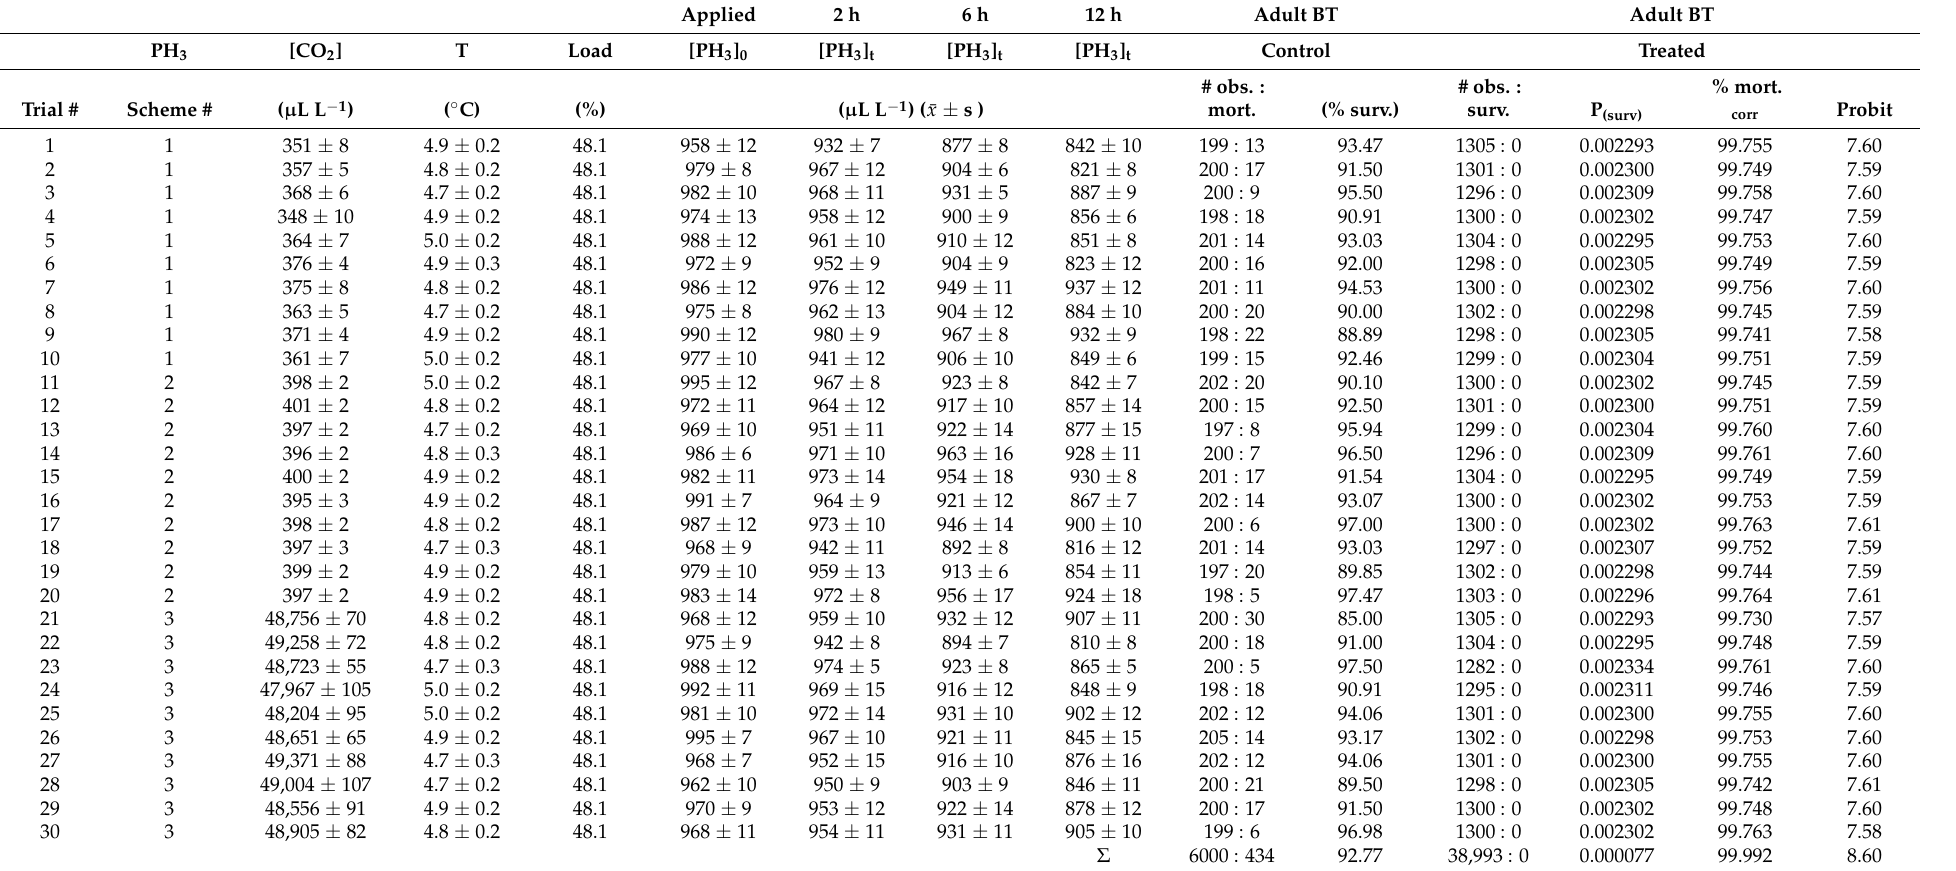
Table 1. Efficacy analysis and parametrics associated with confirmatory fumigations of adult bean thrips (BT), Caliothrips fasciatus, (Pergande) infesting navels of sweet oranges, Citrus sinensis (L.) having pulp temperature ( x ± 2 s ), T , and applied doses of ca. 1.5 g m − 3 (1000 ppmv ( µ L L − 1 )) delivered by three formulations of cylinderized phosphine − 1.6% phosphine by volume in nitrogen—Scheme 1, VAPORPH 3 OS ® —Scheme 2, and ECOFUME ® —Scheme 3—with respective carbon dioxide levels, [CO 2 ] (ppmv = µ L L − 1 ), as well as